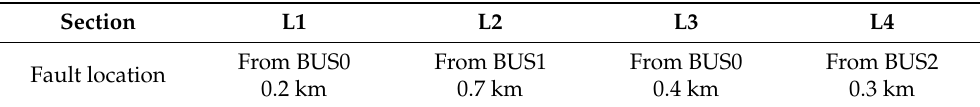
Figure 11. System simulation model. Table 3. Fault location settings.